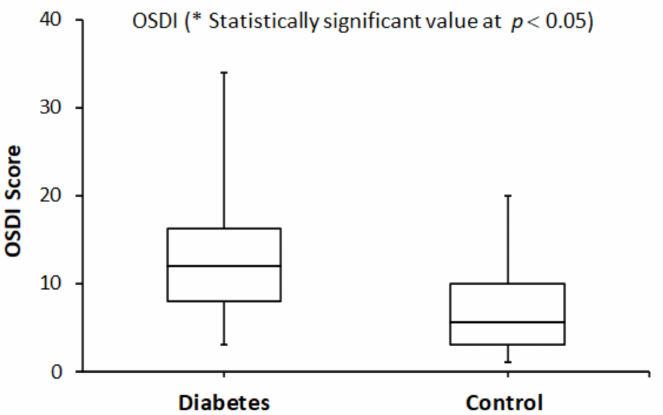
Figure 1. A side-by-side boxplot for the OSDI score within the study (diabetes) and the control (without diabetes) groups. * The difference in the OSDI median score was statistically significant at p < 0.05.